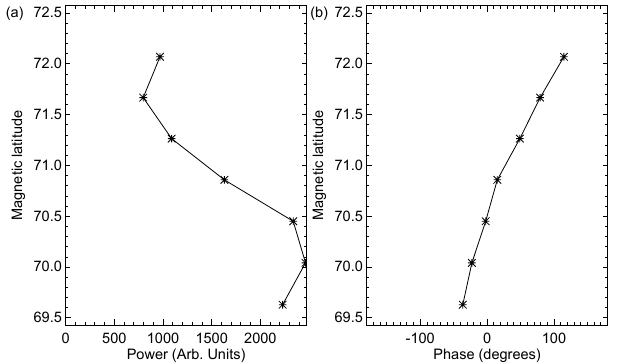
Fig. 5. Fourier (a) power and (b) phase at the peak frequency of the ULF wave observed in the ionospheric drift velocity measured along beam 9 of the Hankasalmi SuperDARN radar as a function of geomagnetic